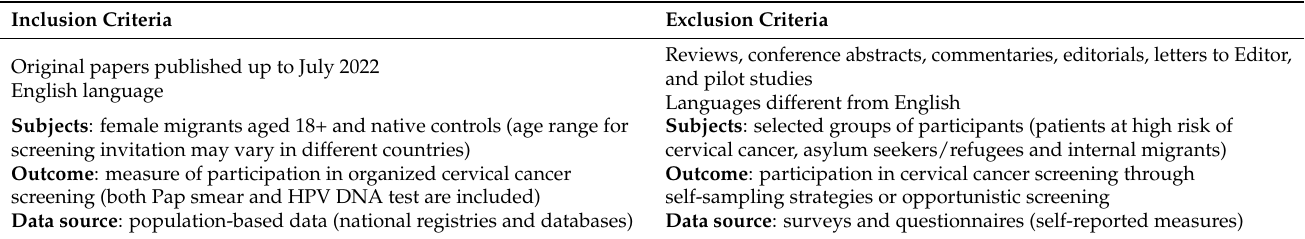
Table 1. Inclusion and exclusion